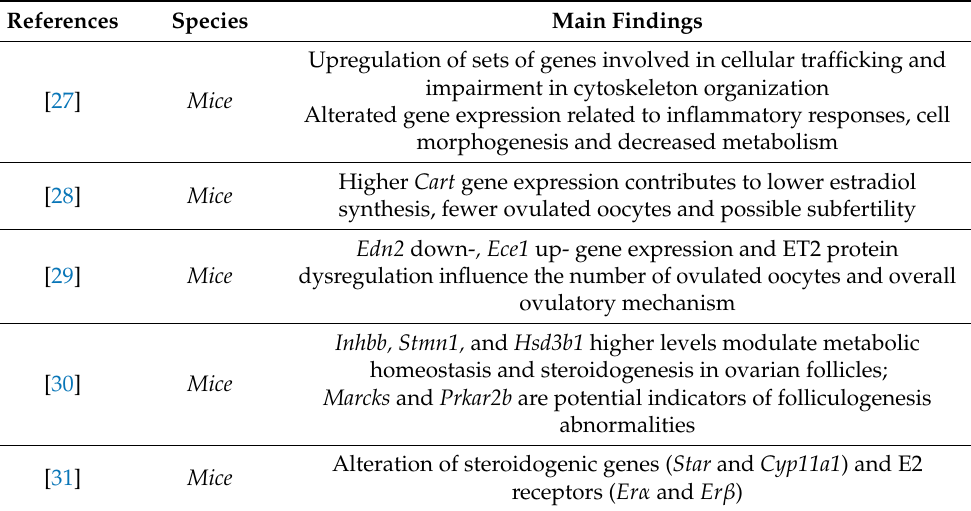
Table 1. Summary table of the main findings related to the impact of a high-fat diet on gene expression of